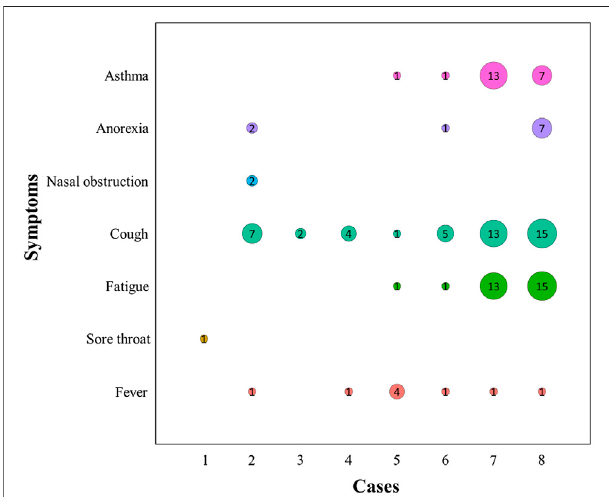
FIGURE 3 | Duration of the major clinical symptom recovery in eight COVID-19 cases. Numbers indicate the days when the major clinical symptoms (asthma, anorexia, nasal obstruction, cough, fatigue, sore throat, and fever) were completely cured. The size of the circle is positively correlated with the number of days.